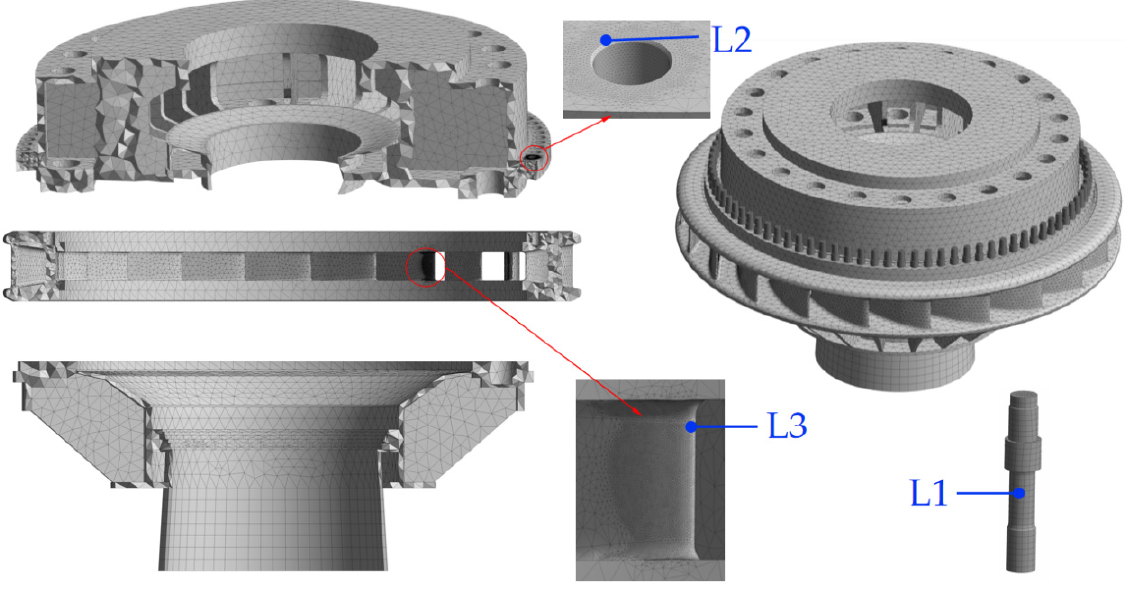
Figure 11. Finite element mesh of the investigated structures.